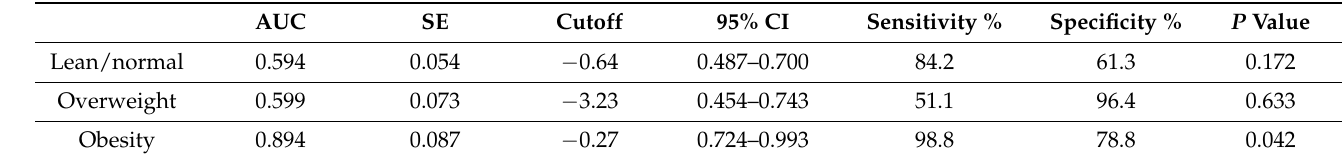
Table 5. Predictive Log( P/B ) performance in LL of whole blood iron among infertile lean/normal, overweight, and obese patients, respectively.